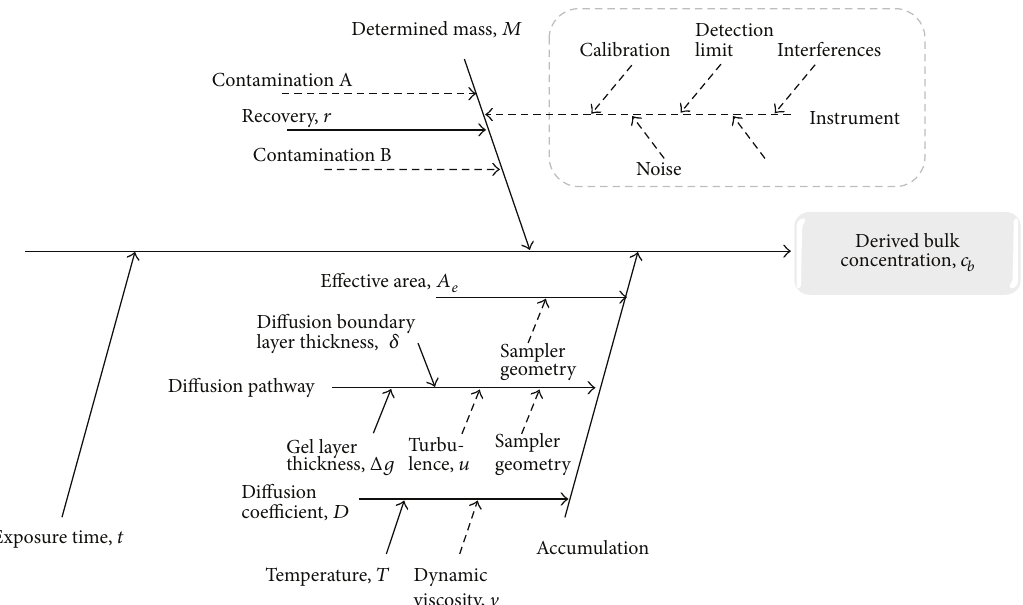
Figure 2: Cause and effect diagram describing the uncertainties associated with the determination of bulk concentration 𝑐 𝑏 , using a passive sampler. Dashed arrows indicates parameters whose uncertainty contribution was included in another parameter. The dashed box shows the uncertainty from instrument determination of analyte. Uncertainty analysis of the ICP-MS technique has been performed previously [19, 22] and was therefore not treated separately in this paper.